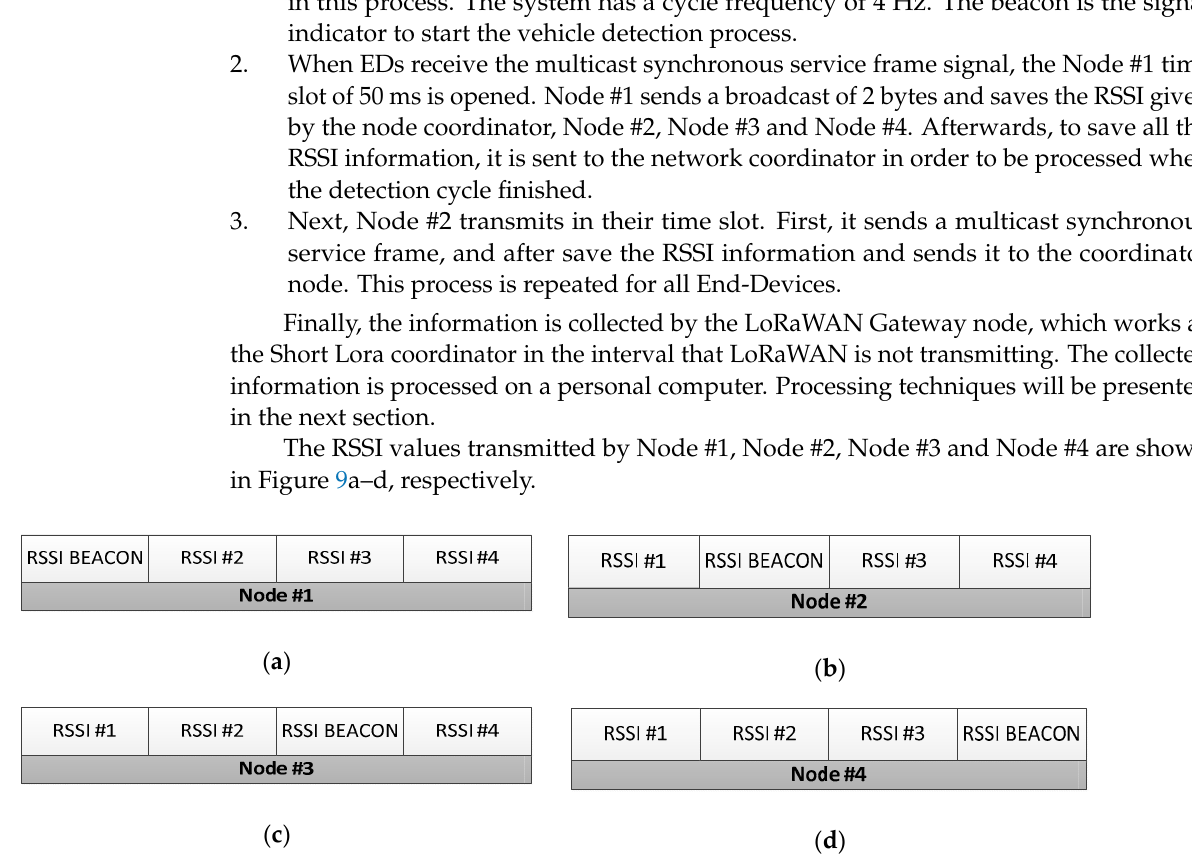
Figure 9. Radio Signal Strength Indicator (RSSI) transmitted for each End-Device to the network coordinator: ( a ) Node #1, ( b ) Node #2, ( c ) Node #3 and ( d ) Node #4.